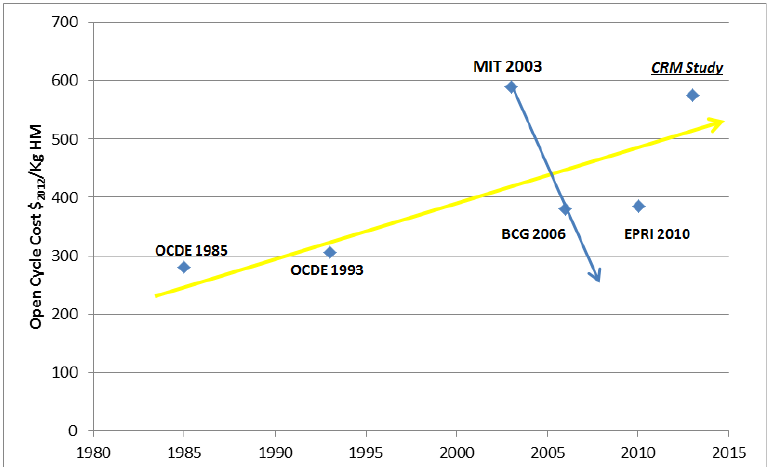
Figure 1. Trend analysis of the cost evolution in the open cycle.